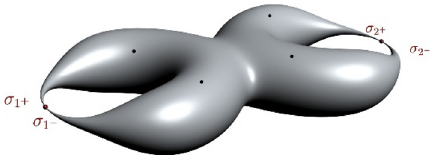
Figure 12 . The bi-nodal sphere with four punctures corresponding to external particles. The loop momentum ‘ = ‘ 1 + ‘ 2 is parametrised by two nodes, corresponding each to a null momentum ‘ 1 ; 2